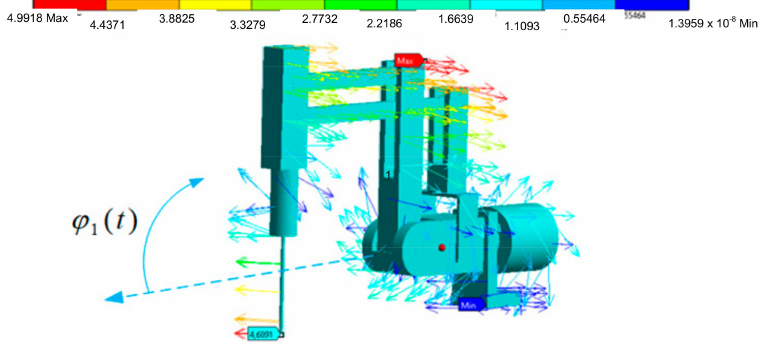
Figure 24. Displacement vector diagram in [mm] for the movement of the surgical robot at the first joint.